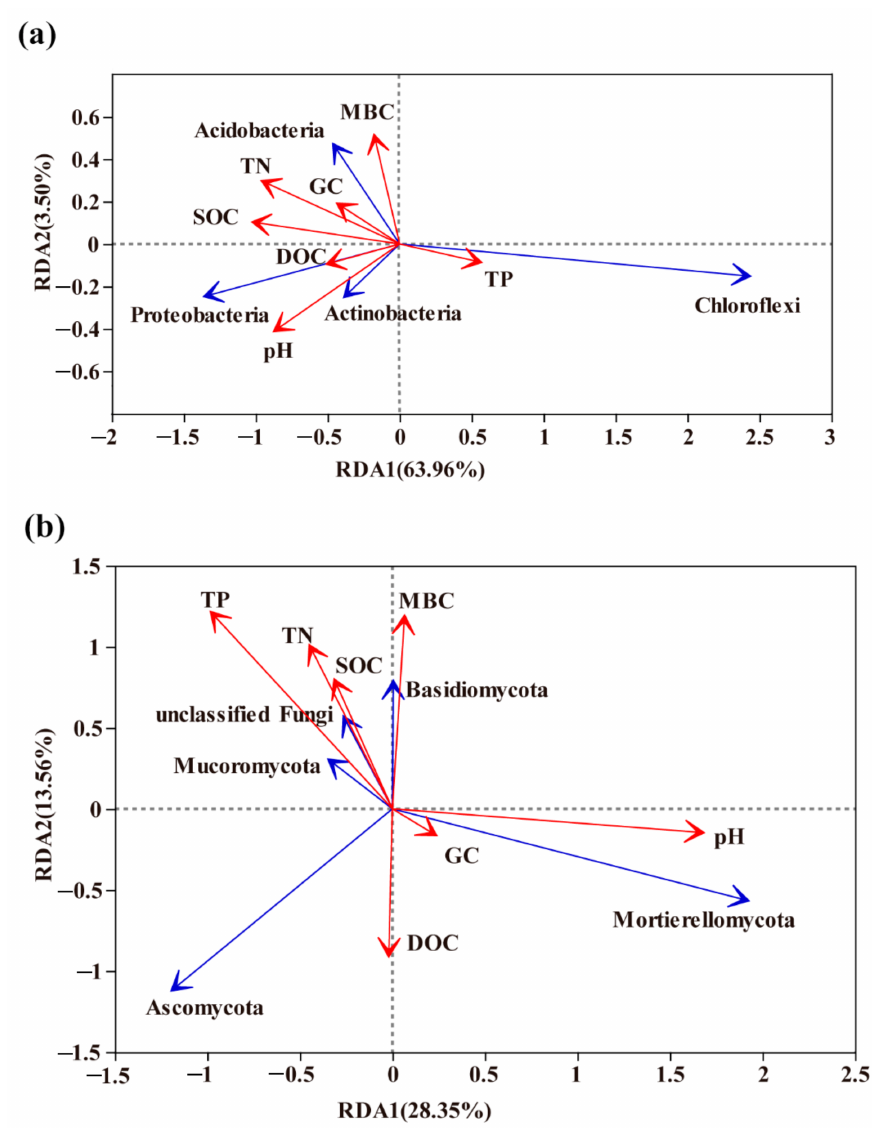
Figure 6. Redundancy Analysis (RDA) ordinate plots show the relationships among bacteria ( a ) and fungal ( b ) phyla ( blue arrow) and soil properties ( red arrow). Arrows indicate the direction and magnitude of